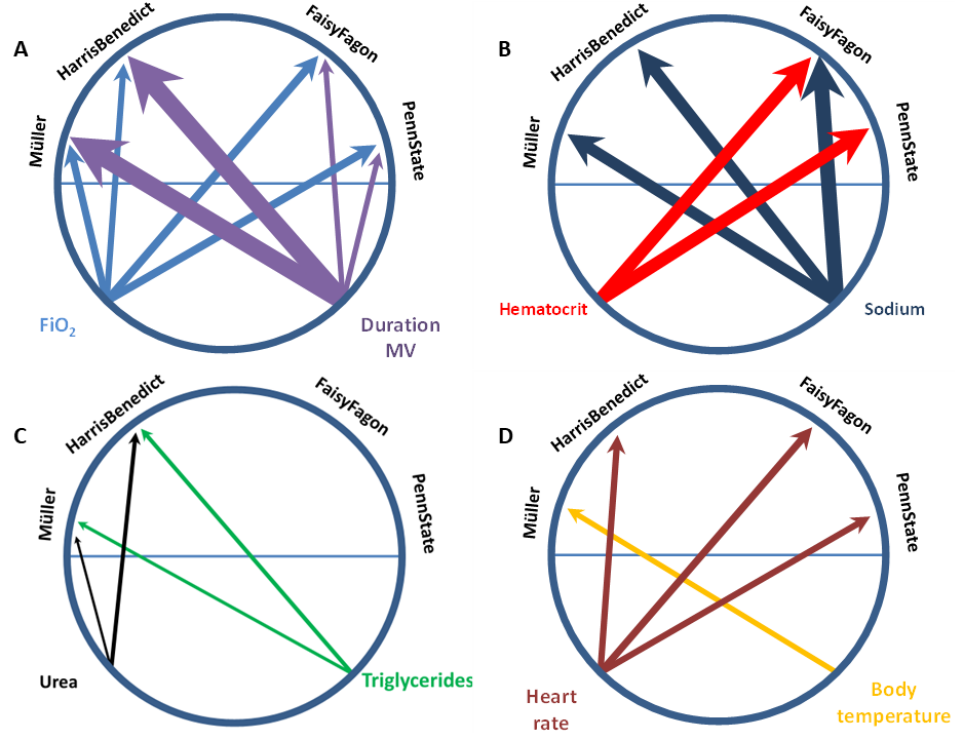
Figure 3. Variables independently associated with differences between estimated and measured resting energy expenditure in the critically ill patient cohort. Predictive equations developed for healthy persons are shown at the upper left side, and predictive equations developed for critically ill patients are shown on the upper right side of each panel. Panel ( A ) depicts respiratory (blue and purple), Panel ( B , C ) laboratory (red, dark blue, green, black), and Panel ( D ) circulatory and energy homeostasis variables (brown and yellow). The extent to which each variable explains differences between the two measurement methods (corresponding to change in R 2 from Table 3) is represented by thinner or thicker arrows pointing to the respective predictive equation. For example, the duration of MV explains 26.6% (R 2 of 0.226) of differences between measured resting energy expenditure and estimated resting energy expenditure using the equation of Müller (thicker purple arrow pointing to Müller), but only 7.9% (R 2 of 0.079) of differences between measured resting energy expenditure and estimated resting energy expenditure using the PennState equation (thinner purple arrow pointing to PennState). Abbreviations: FiO 2 : Fraction of inspired oxygen; MV: mechanical ventilation; sodium: serum sodium